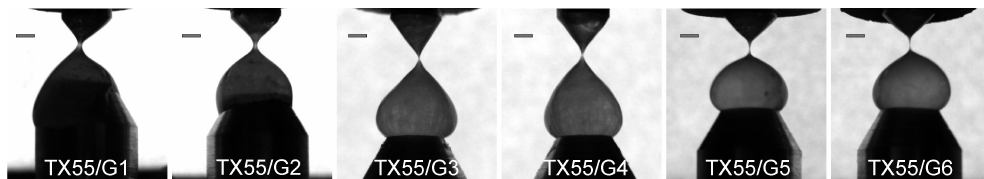
Figure A1. Smectic bridges under normal gravity conditions in the same setup and with the same materials as in the TX55 flight, in a test run before the rocket launch. Each image shows the respective bridge within the last 20 ms before pinch-off. The TX55/G n labels refer to the chambers of TX55/ n . The scale bars mark 1 mm.